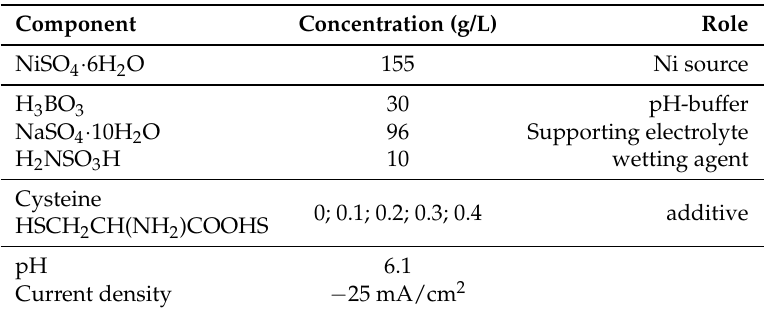
Table 1. Composition of the electrolyte bath containing